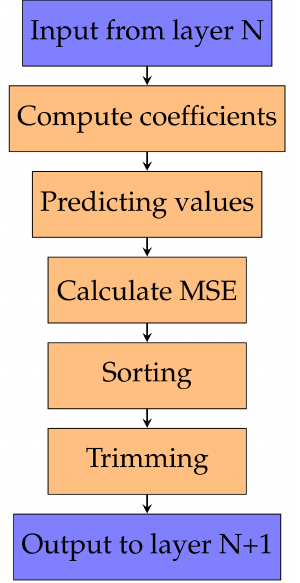
Figure 6. The training steps of the GMDH